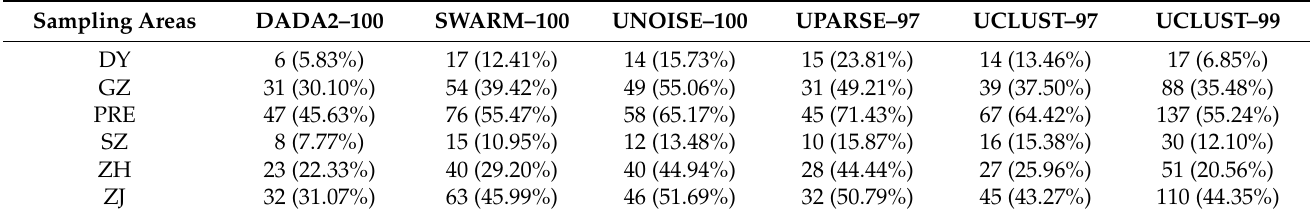
Table 2. Number and proportion of oligotrich (s.l.) OTUs/ASVs in each sampling area from the six datasets. The proportions in parentheses indicate the ratio of the oligotrich (s.l.) OTU/ASV number in each sampling area to the total number of oligotrich (s.l.) OTUs/ASVs within each